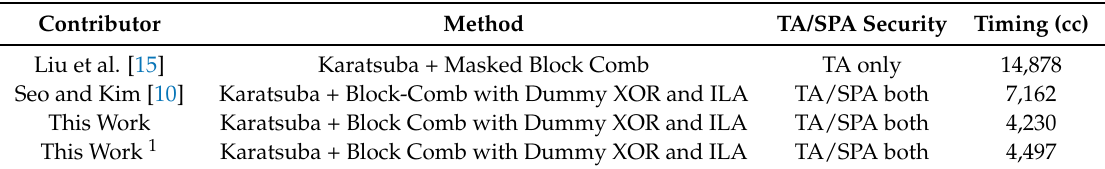
Table 6. Comparison of binary field multiplication in terms of execution timing (in terms of clock cycles) and countermeasures. 1 : register optimized version.